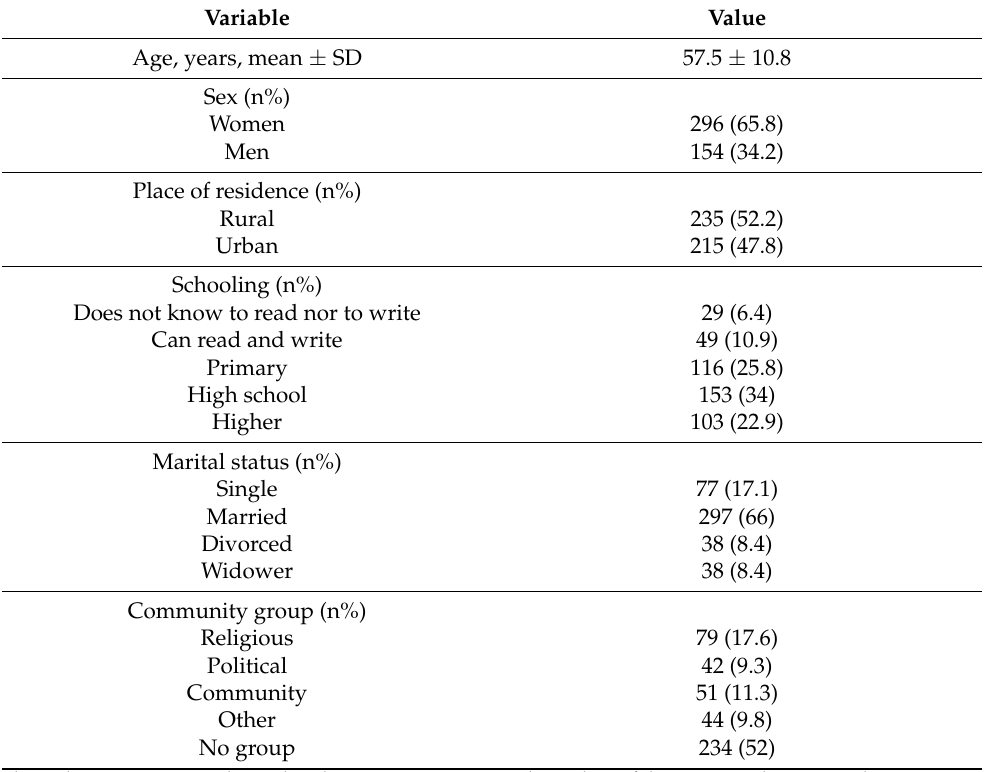
Table 1. Sociodemographic characteristics of the sample ( n =